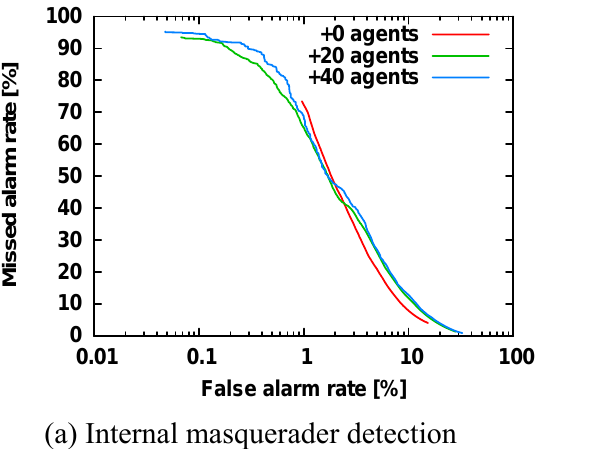
Figure 6. ROC curves for detection of internal masqueraders (a) and external masqueraders (b) for the number of additional agents, keeping N int = 5 and N ext = 5. All other parameters are the same as in Figure 3. The horizontal axis is a logarithmic scale, so we can focus on the missed alarm rate at the low false alarm